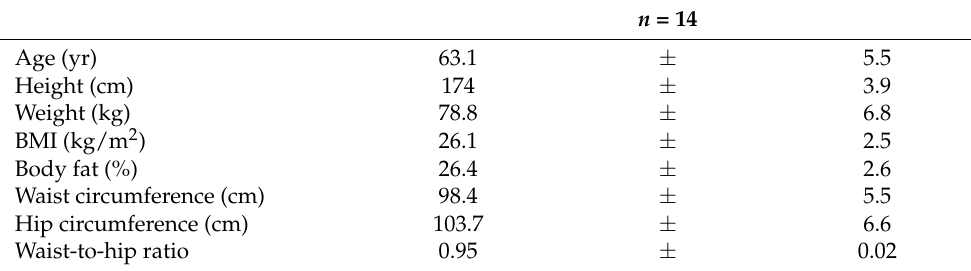
Table 1. Anthropometric characteristics of the participants (mean ±